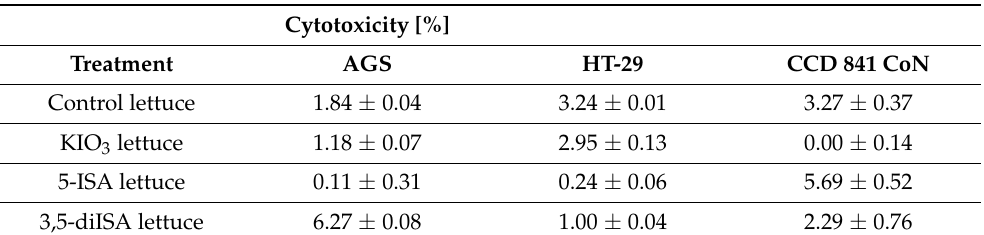
Table 1. Cytotoxicity of extracts from iodine-biofortified lettuce in human gastrointestinal cell line (AGS), colorectal adenocarcinoma cell line (HT-29) and normal colon epithelial cell line (CCD 841 CoN).